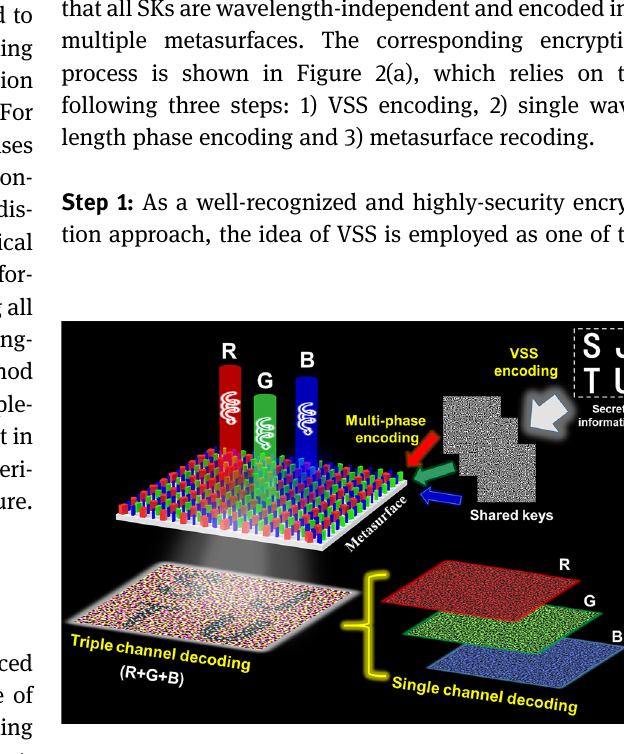
Figure 1: Schematic diagram of the SSPE scheme with multi- wavelength